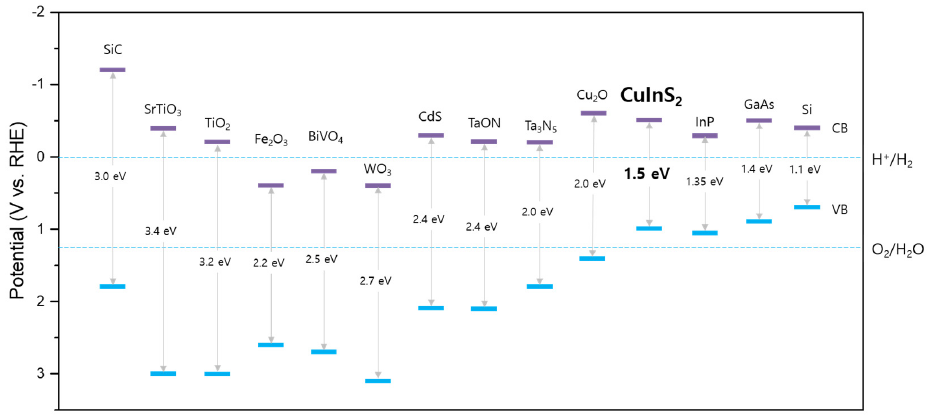
Figure 2. Bandgap and band position of various semiconductors.